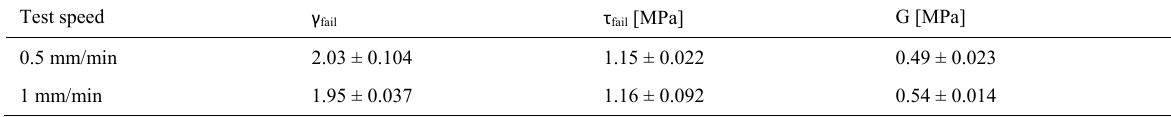
Table 4: Characteristics of Sikasil ® SG-500 in shear ( γ fail = average shear strain at failure, τ fail = average shear stress at failure, G = shear modulus).